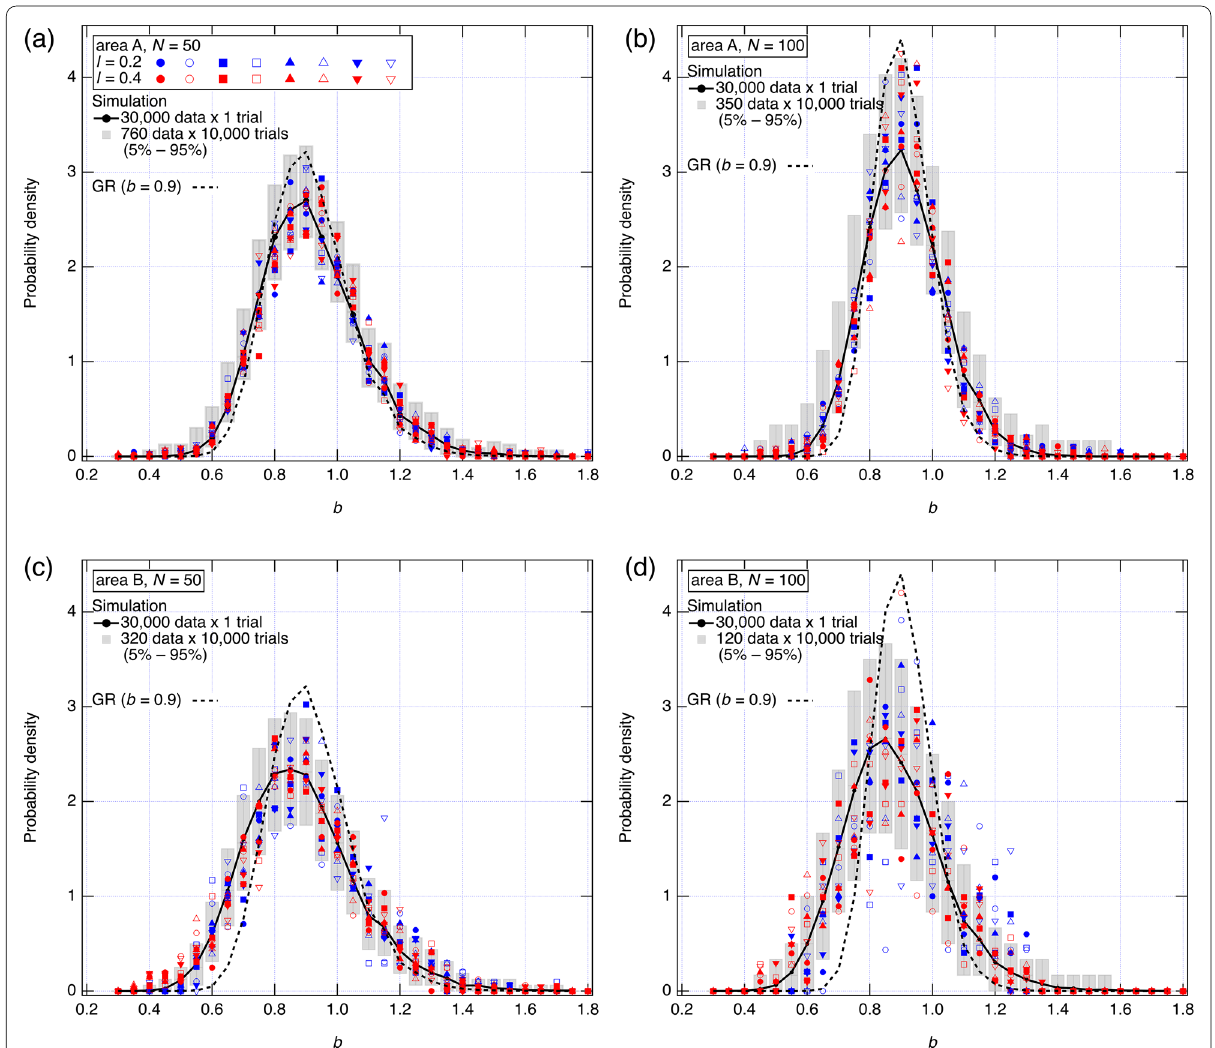
Fig. 15 Typical probability density distributions of b , showing all eight patterns of non-overlapping data acquisition for each pair of N and l . The open and closed symbols with the same shapes and colors indicate that they are the result for the same spatial gridding but event number window shifted half. The black solid lines and gray bars show the PDD and its variability estimated by the model shown in the text. The dashed black lines are the PDDs expected from the GR law for a constant b -value of 0.9. a N